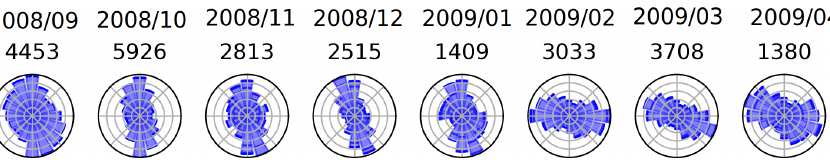
Figure A2. Monthly directional distributions of internal d (cid:49) H / d t at Kevo (KEV), 2008/09 to 2009/04. The number of data points is plotted under the year and month label. | d (cid:49) H / d t | > 0 . 5nTs − 1